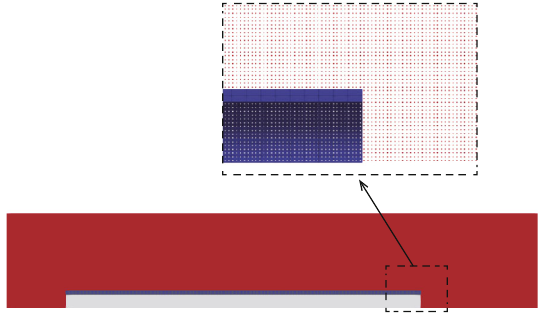
Figure 8: The con fi guration of the underwater cylinder test by CFEMP.